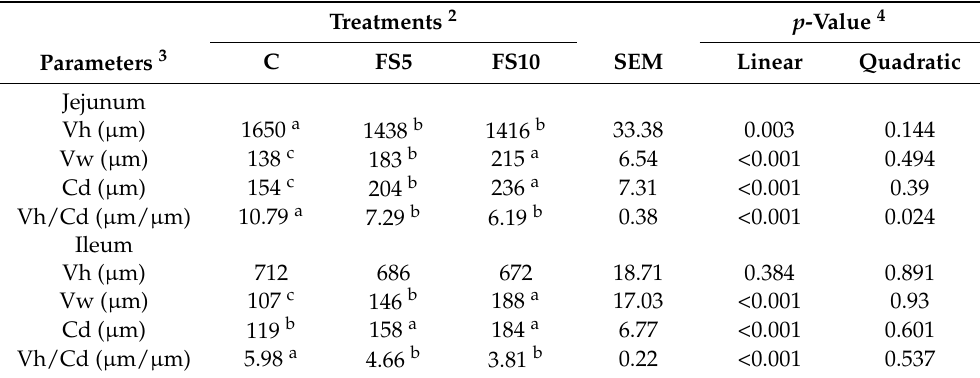
Table 7. Effect of the dietary FS inclusion on the histomorphology of jejunum and ileum of broiler chickens 1 .